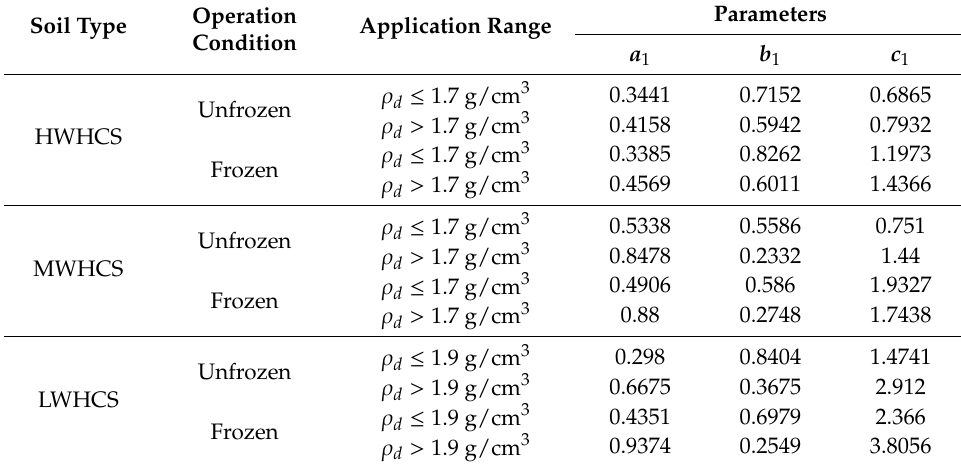
Table 4. Binary fitting parameters for three soil clusters.